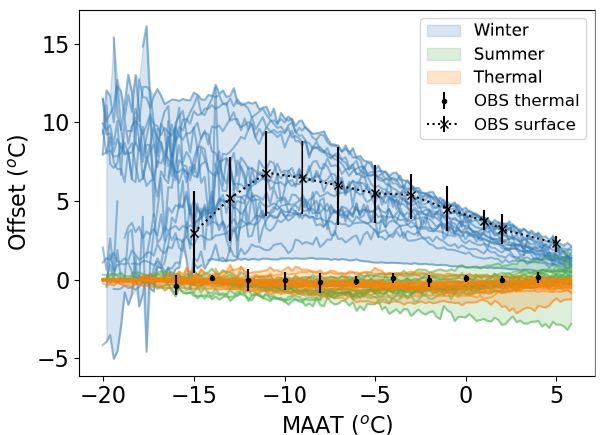
Figure 6. Multi-model ensemble spread of the median winter, me- dian summer and median thermal offsets for the CMIP6 multi- model ensemble. Individual models for the CMIP6 multi-model ensemble are shown as lines and identified in Fig. S1.3 and for the CMIP5 multi-model ensemble in Fig. S2.5. The observed sur- face and thermal offsets summarised from the available point data (Zhang et al., 2018) are added in black. Although the observed sur- face offset is not directly comparable with the separate winter and summer offsets, these are shown for the models to illustrate their relative